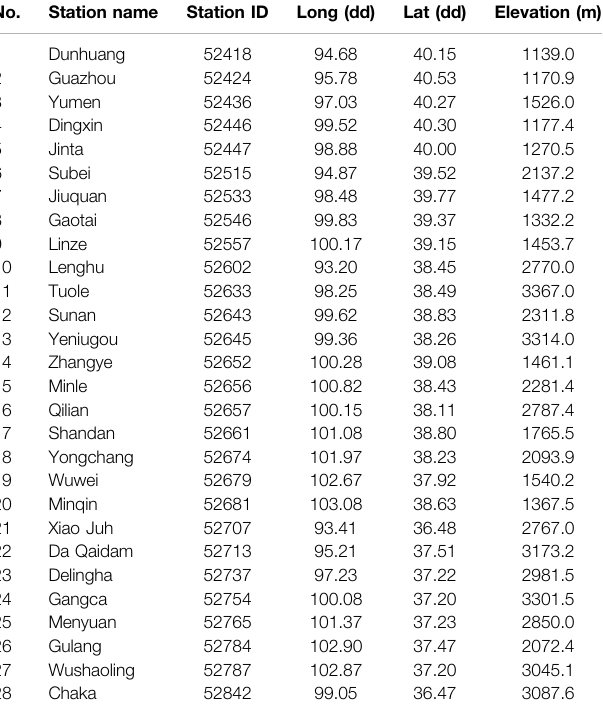
TABLE 1 | Location information of the basic weather